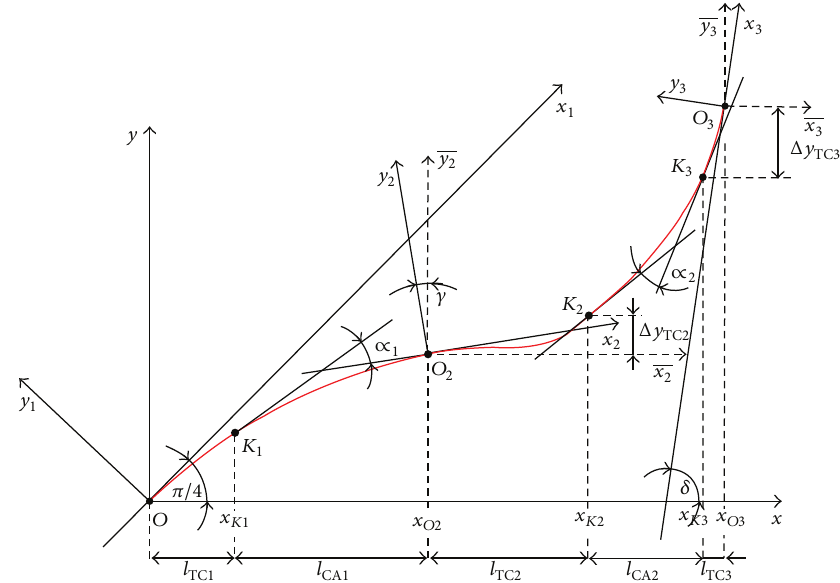
Figure 1: The geometrical layout under consideration in the local coordinate